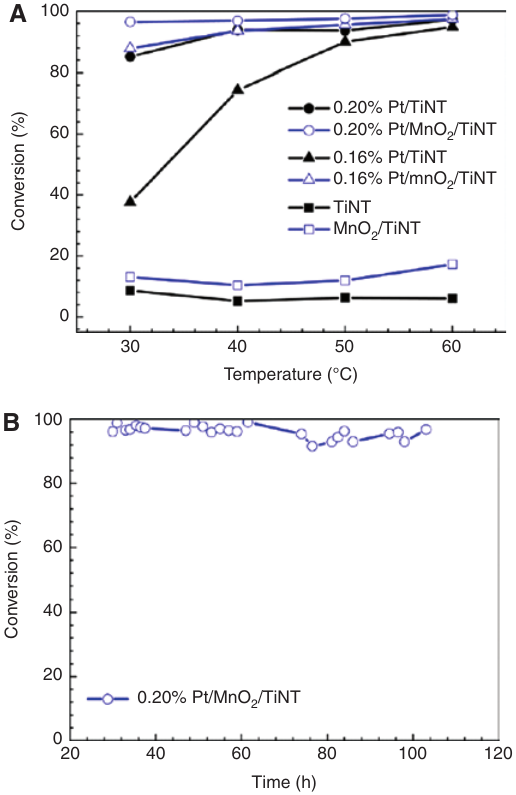
Figure 12: (A) Dependence of HCHO conversion on reaction temperature for TiNT, MnO TiNT, 0.20% Pt/TiNT and 0.20% Pt/MnO trace HCHO oxidation over 0.20% Pt/MnO from [72] with permission from the American Chemical